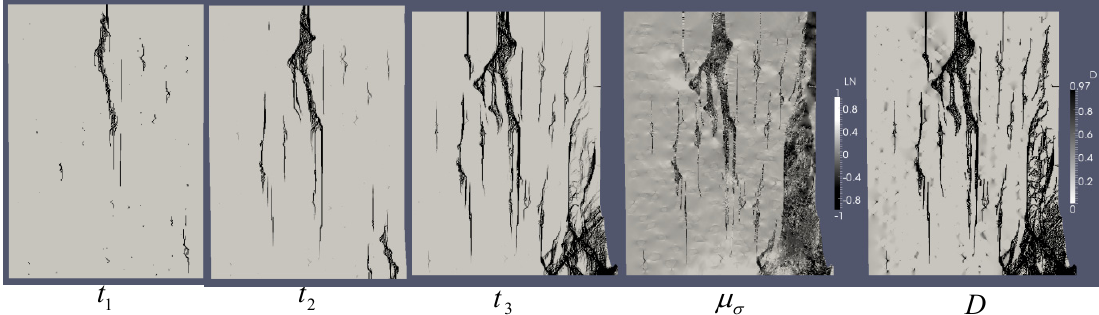
 ), damage function ( D ) in the 